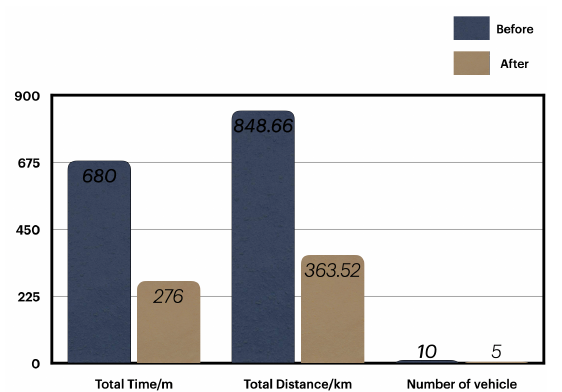
Figure 6. A graph showing the difference between the results before and after applying the pro- posed